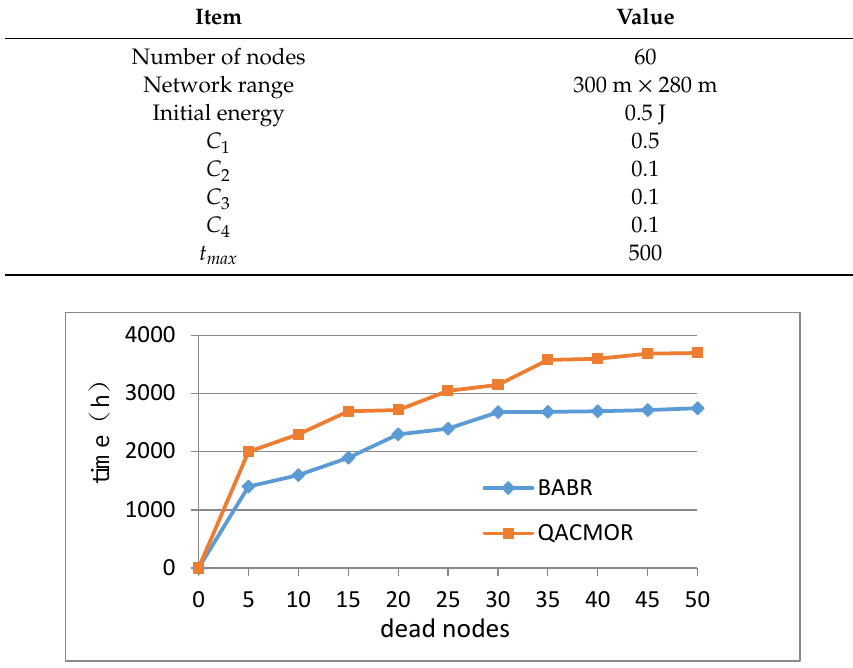
Figure 11. Comparison of network lifetimes in a continuous steel casting line.